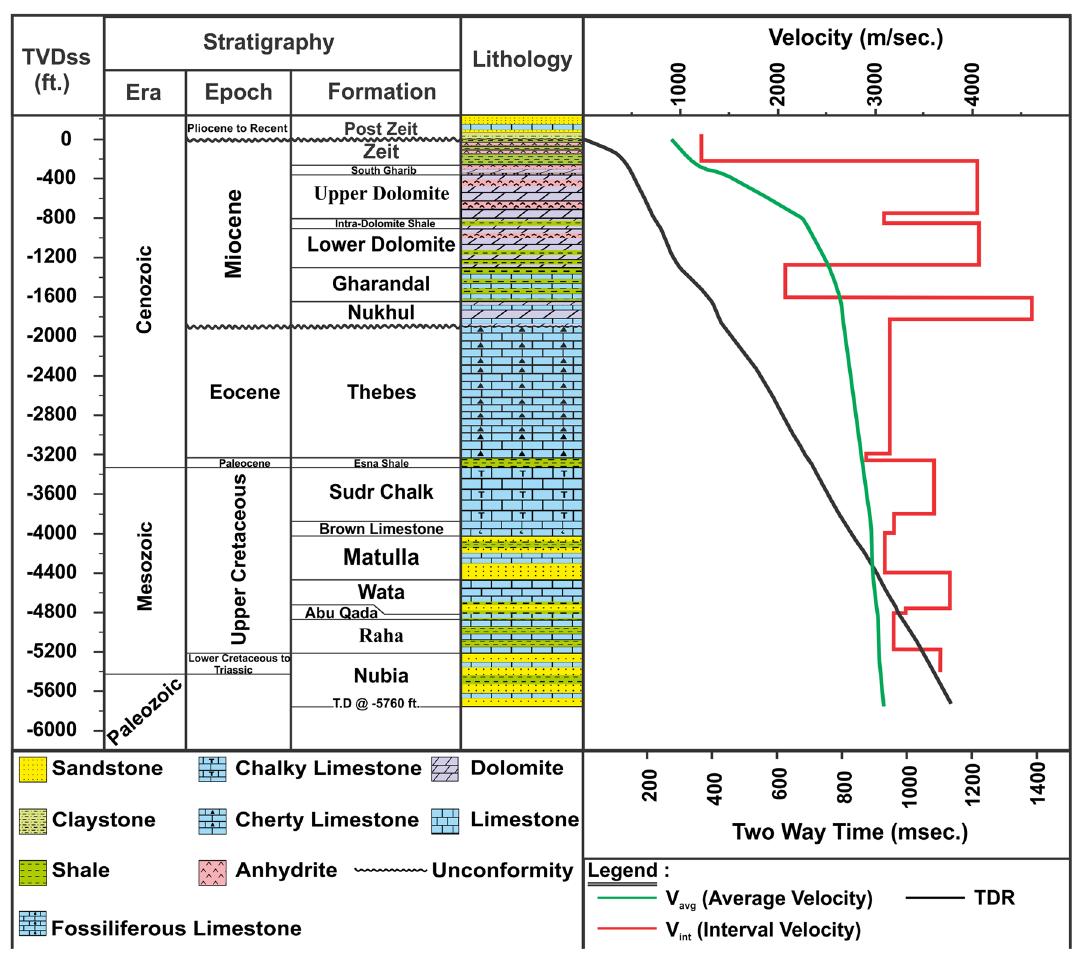
Fig. 3 The ISS-08 well velocity survey demonstrates the time-depth relationship derived from available density and sonic logs. The green curve represents the calculated average velocity, while the red curve